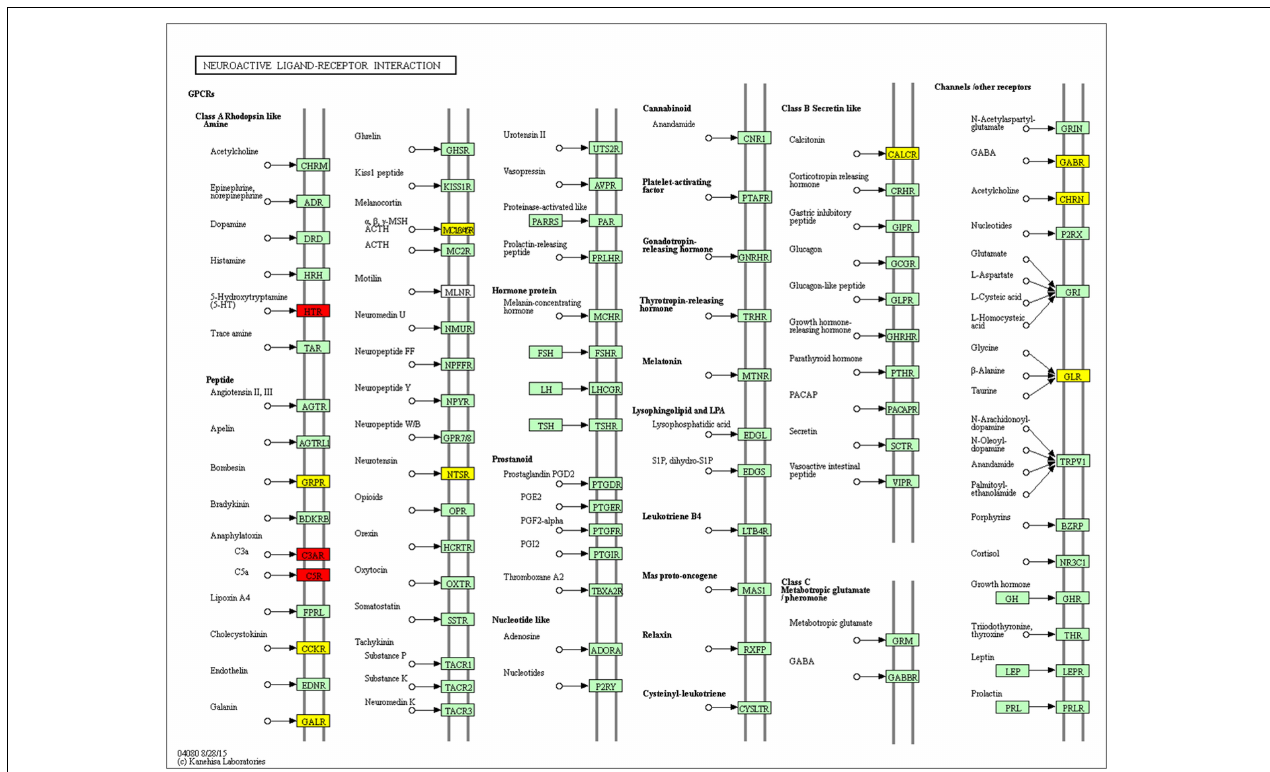
FIGURE 10 | Significantly enriched KEGG pathways in neuroactive ligand–receptor interactions. Up-DEGs are marked in red. Down-DEGs are marked with yellow. The pictures were drawn by KEGG Mapper